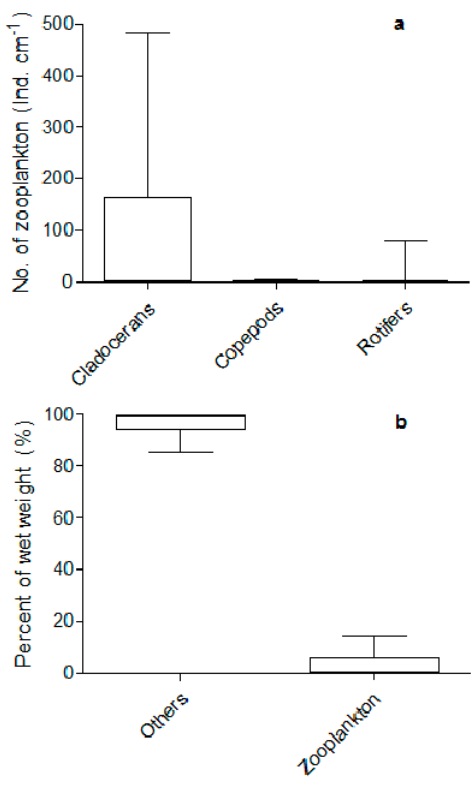
Figure A3. Box plot (median, box 25, and 75 percentiles, whisker min to max) of No. of zooplankton in the gut content of crucian carp ( a ) and the wet weight % of the diet in MDB ( n = 14) ( b ).